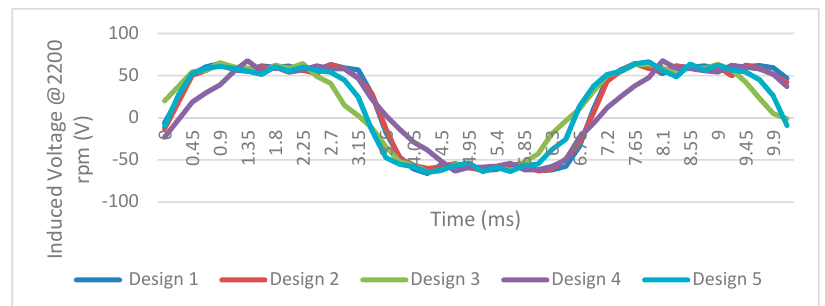
Figure 10. Back EMF results.